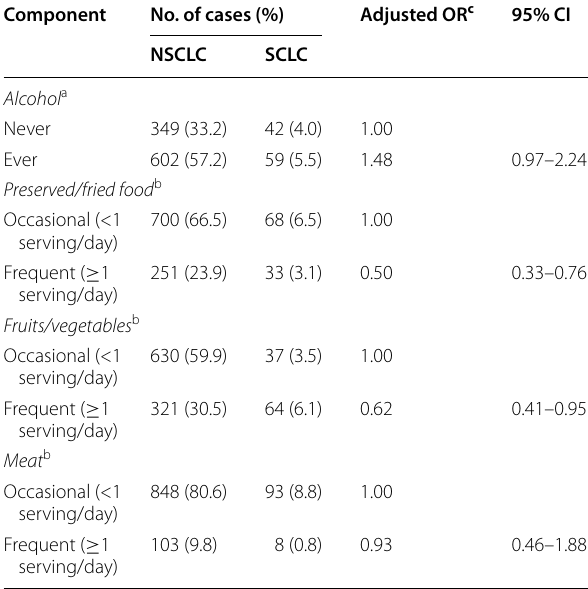
Table 4 Associations of alcohol consumption and dietary habits with lung cancer histology in 1052